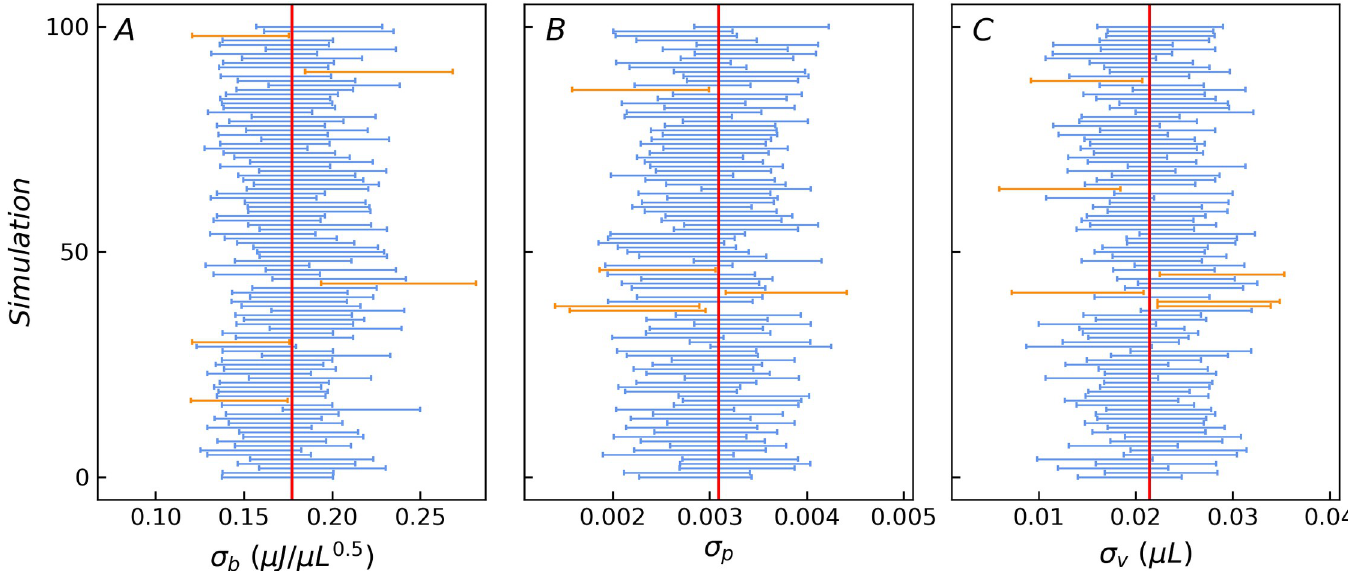
Fig 5. The 95% confidence interval estimates of the three error parameters for 100 samples. The vertical red lines are the true value of the three error parameters. The blue bars indicate the 95% confidence intervals (total four standard deviations wide) containing the true value, while the orange bars indicate the opposite.